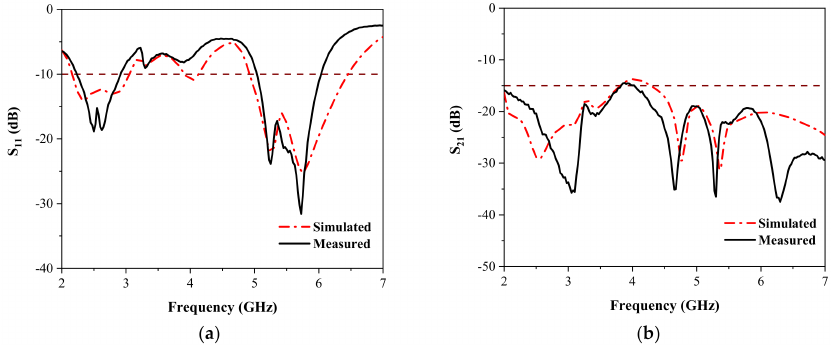
Figure 7. Simulated and measured S-parameters of presented antenna. ( a ) S 11 ; ( b ) S 21 .